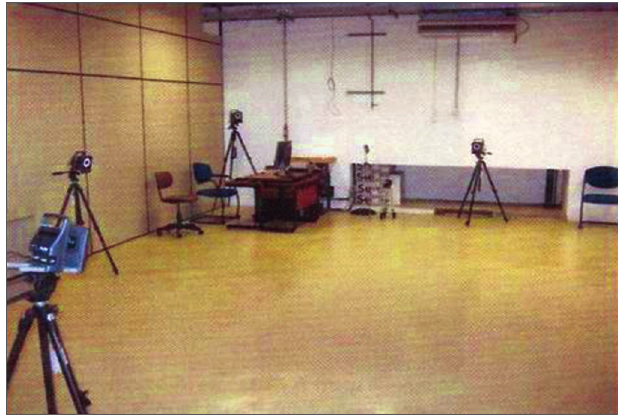
Figura 2. Sala de captura de movimento.